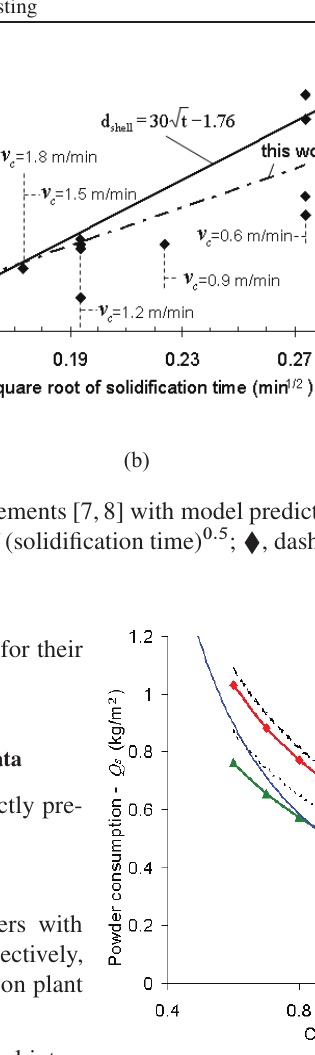
Figure 4. Powder consumption ( Q s ) as a function of cast- ing speed